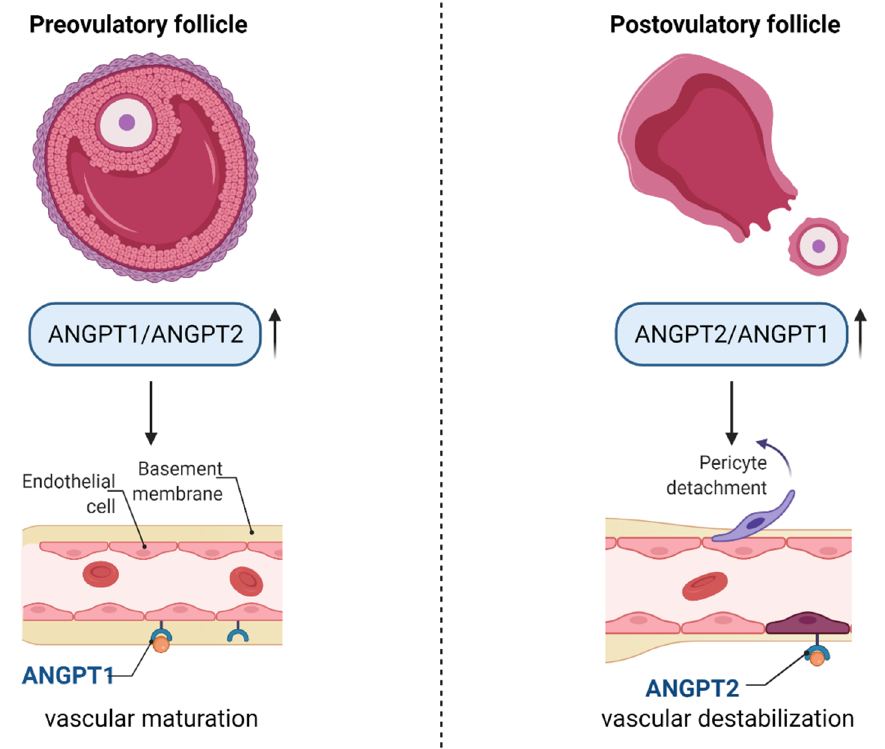
Figure 2. The role of angiopoietins in pre- and post-ovulatory follicles. Before ovulation, the ANGPT1/ANGPT2 ratio increases, leading to vascular maturation, whereas after the LH surge, the level of ANGPT2 increases compared to ANGPT1, leading to the destabilisation of vessels and pericyte detachment. Abbreviations—ANGPT1: angiopoietin 1; ANGPT2: angiopoietin 2. (Created with BioRender.com, accession date: 29.05.2021).